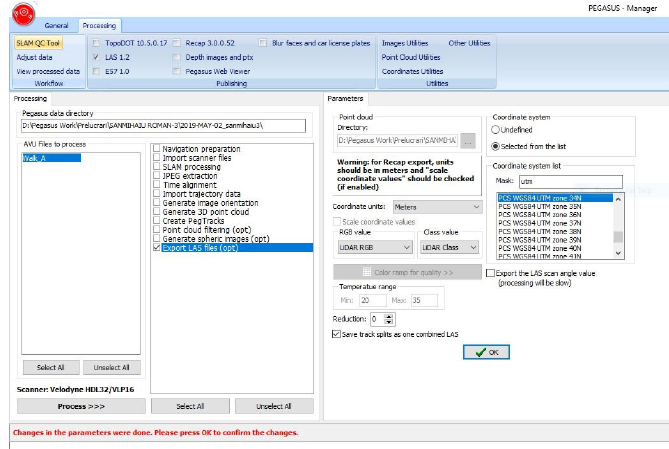
Figure 37. View time-adjusted point clouds on GCP. Figure 37.